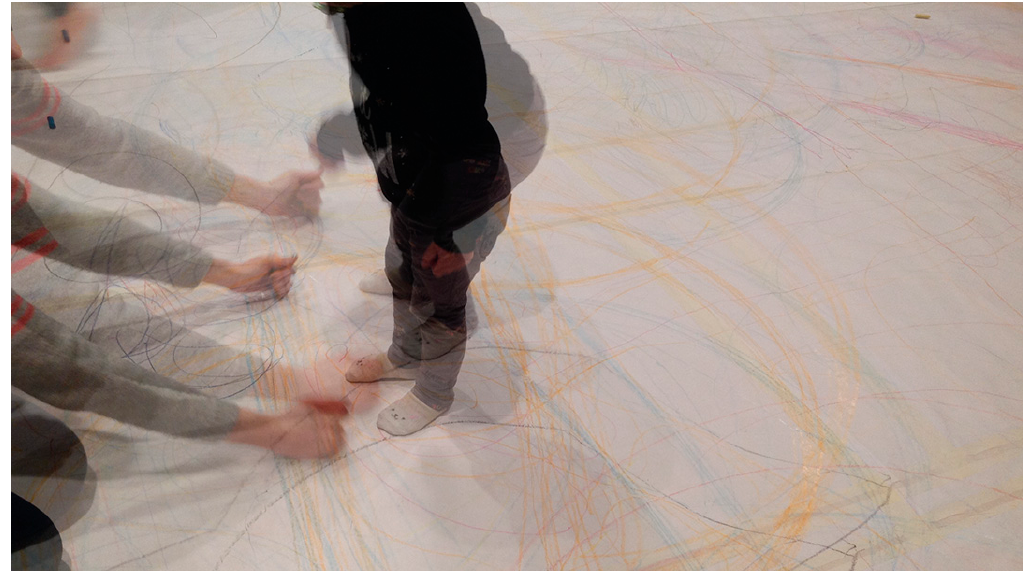
Figure 2. Collective mark-making #1: mother marking around the body of her three year old daughter, as in turn her daughter retraces marks with her feet and body, skipping and squatting.